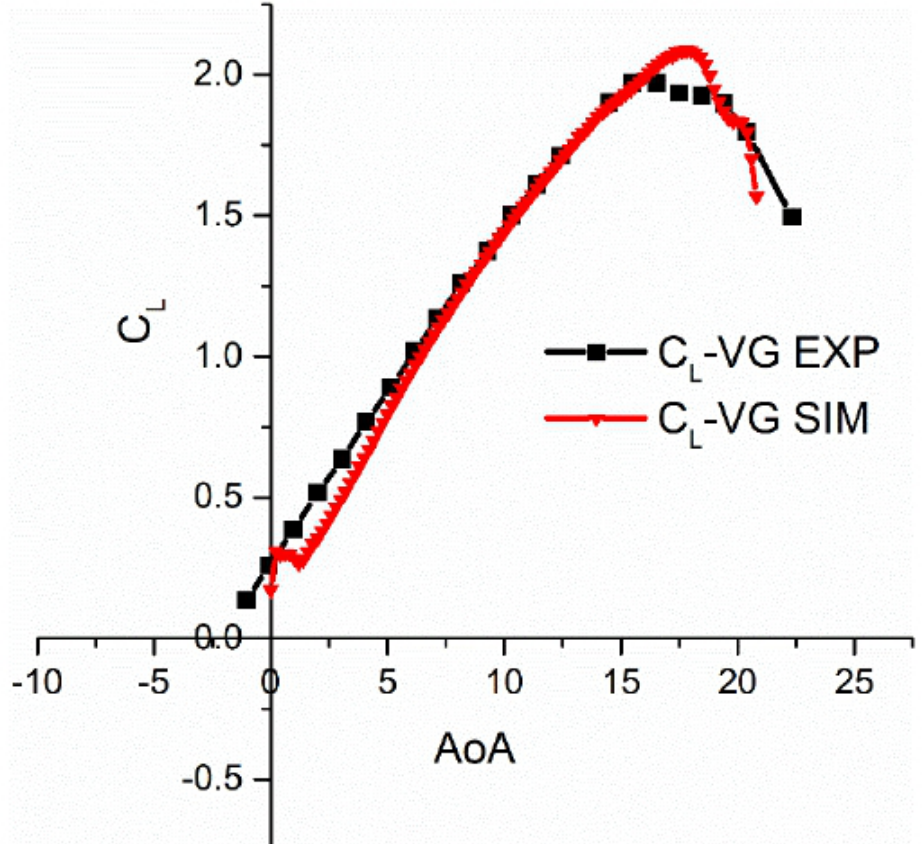
Figure 9. Comparison between the simulation results and experimental results of the lift